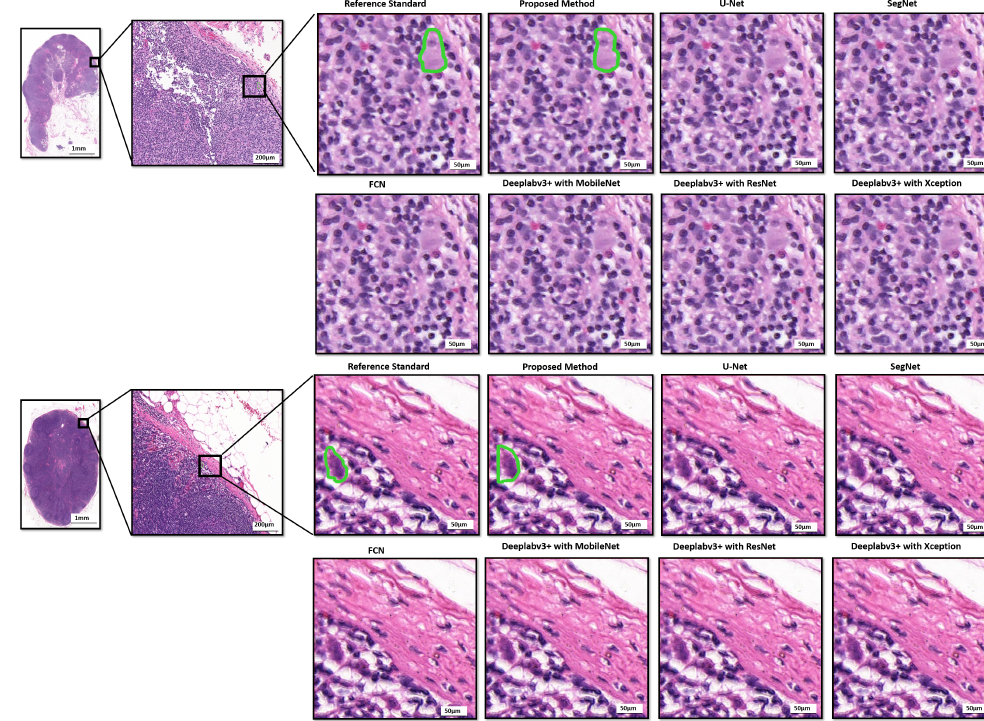
Figure 7. Comparison of the proposed method and the baseline approaches for the segmentation of tiny metastatic foci in challenging cases with isolated tumor cells. The results show that the proposed method is capable of effectively segmenting the tiny metastasis foci, while the baseline approaches tend to fail in segmenting the tiny metastasis